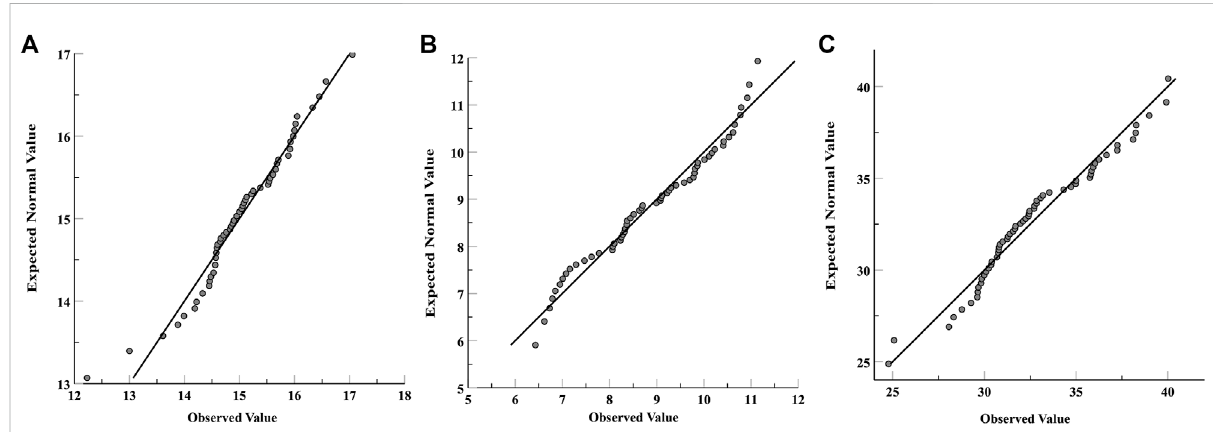
FIGURE 2 Quantile – quantile plots (Q-Q plots) of the concentration of Na + (A) , Cl- (B), and SO 4 2 - (C) in the S22 spring.